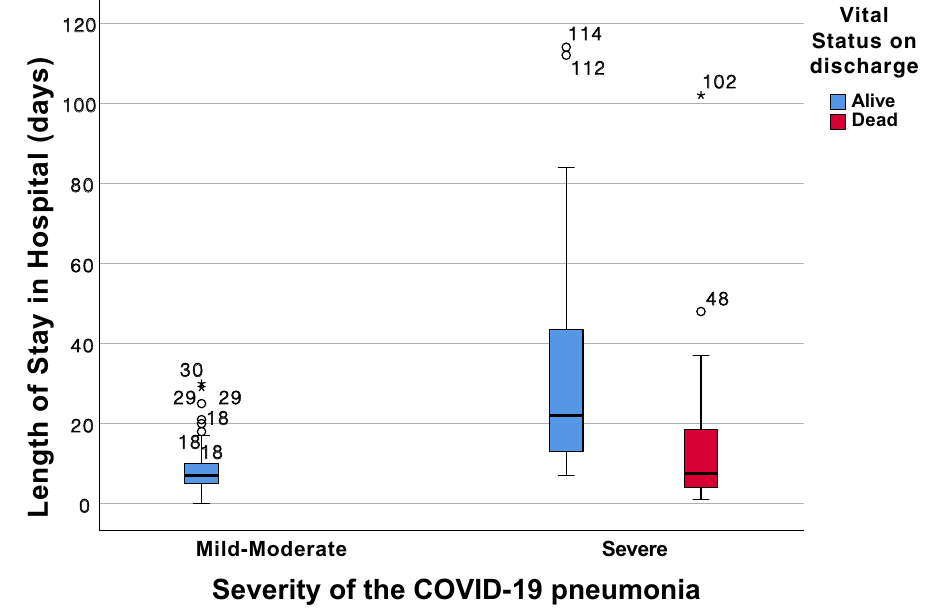
Figure 2. Relationship between length of stay in hospital, severity and vital status on discharge. Box plot showing the length of stay in hospital, according to the severity of the disease and status at discharge. Numbers in the graph area indicate length of stay.